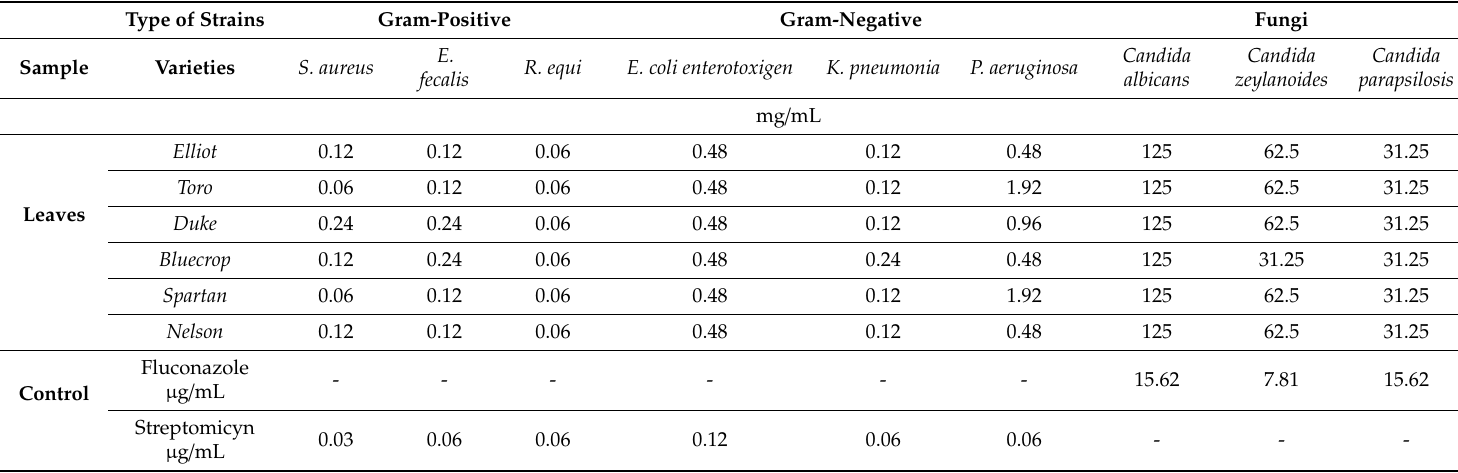
Table 4. Minimum bactericidal concentration (MBC / MFC) of the leaf extracts from the six Romanian blueberry varieties, expressed as mg / mL. Type of Strains Fungi Sample mg / mL